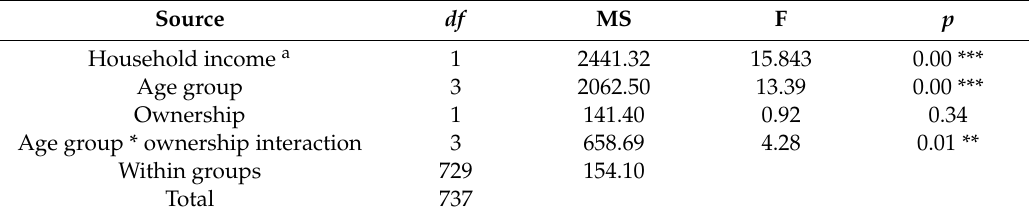
Table 5. ANOVA of impact of ownership and age on